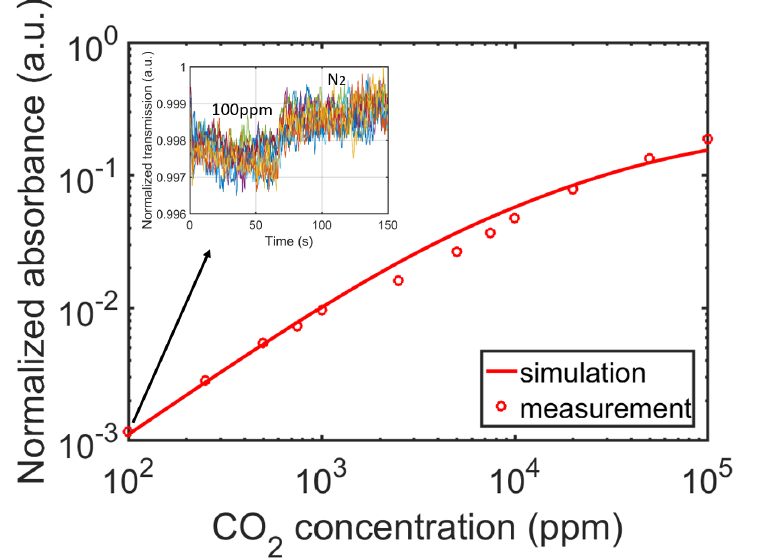
Figure 9. Normalized absorbance of the sensor at various CO 2 concentrations. The inset shows the step response of the sensor at CO 2 = 100 ppm, with 10 measurements superimposed in one